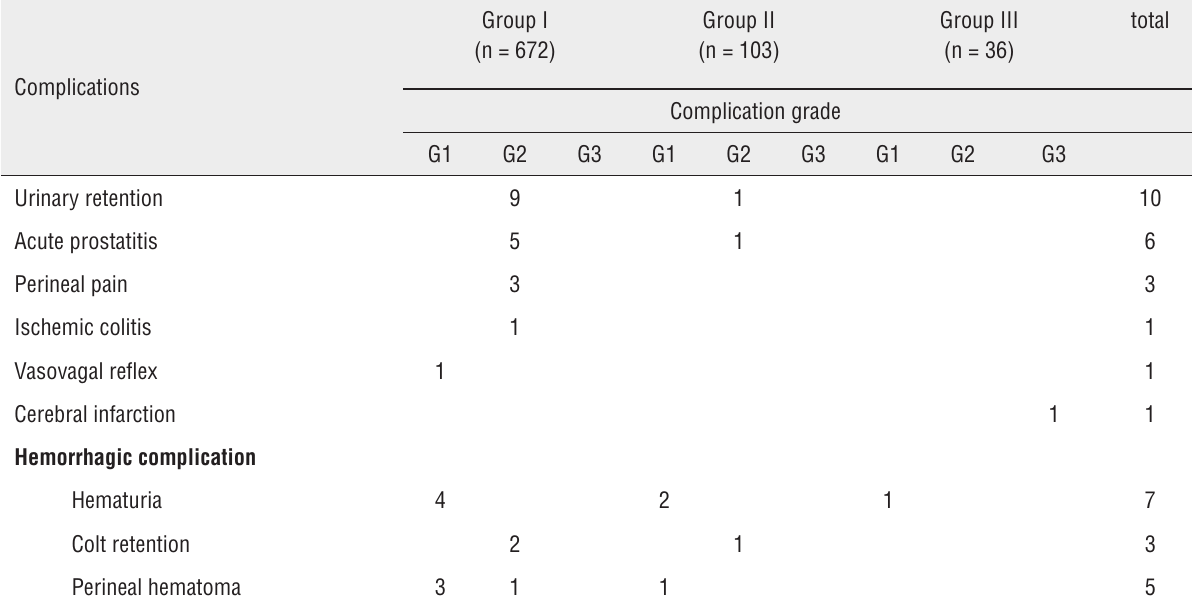
Table 3 - Incidence of complications among the three groups.